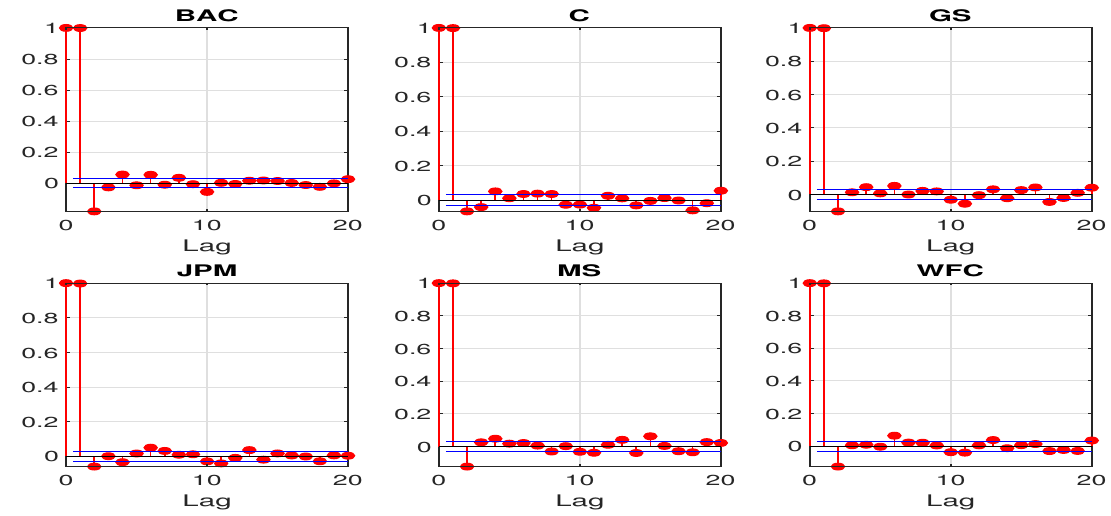
Figure 3. First 20 sample partial autocorrelations for daily log CDS